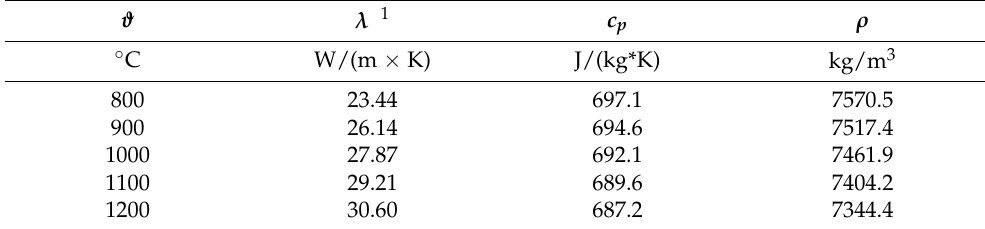
Table 2. Material parameters used in temperature model for 1.7725